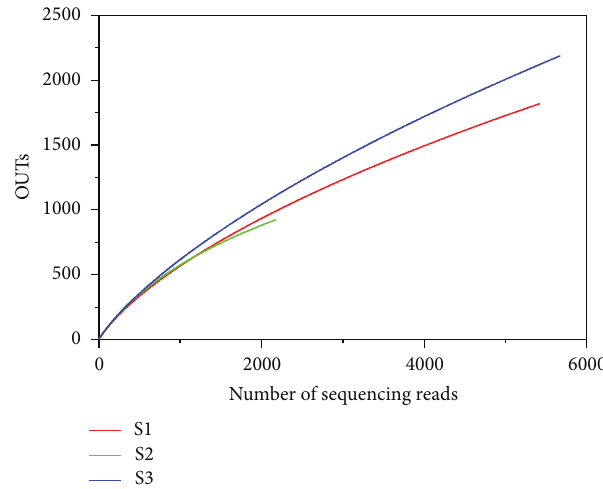
Figure 6: Rarefaction curves indicating the observed number of OTUs within the 16S rRNA gene sequences at the three depths sampled (S1 = 30cm, S2 = 60cm, and S3 = 90